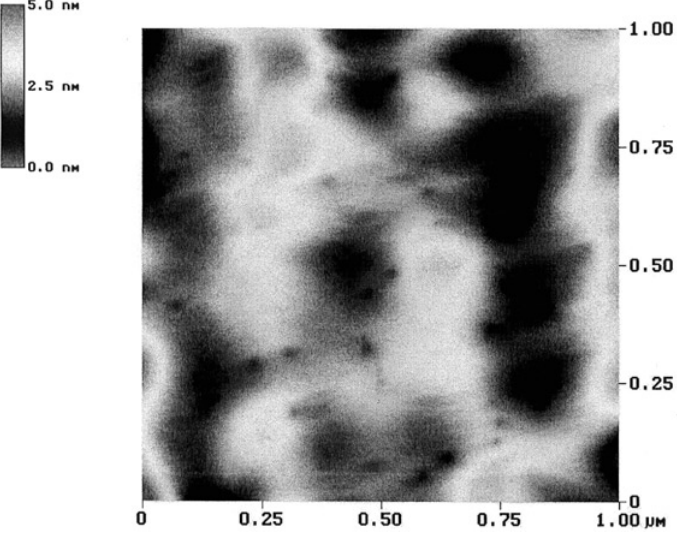
FIGURE 8 The measured surface roughness by AFM with a root-mean-square value of